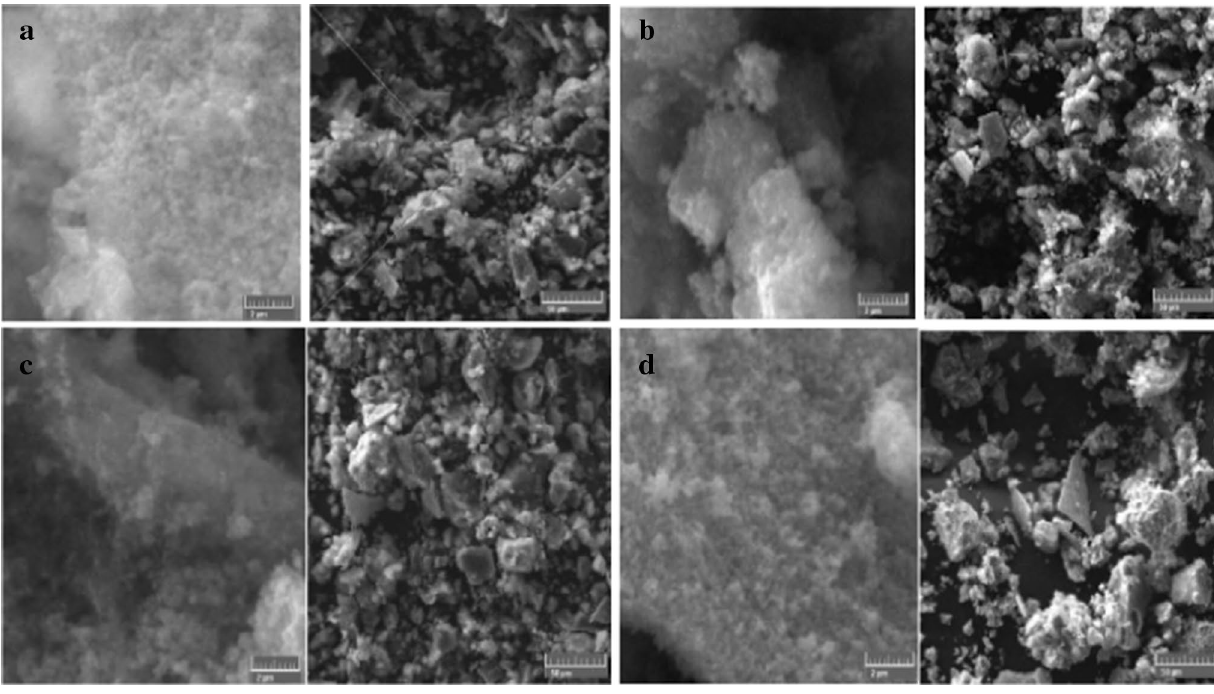
Fig. 7 SEM image of prepared ZnO nanoparticles a as-synthesized b calcined at 500 °C for 3 h (Jurablu et al. 2015)